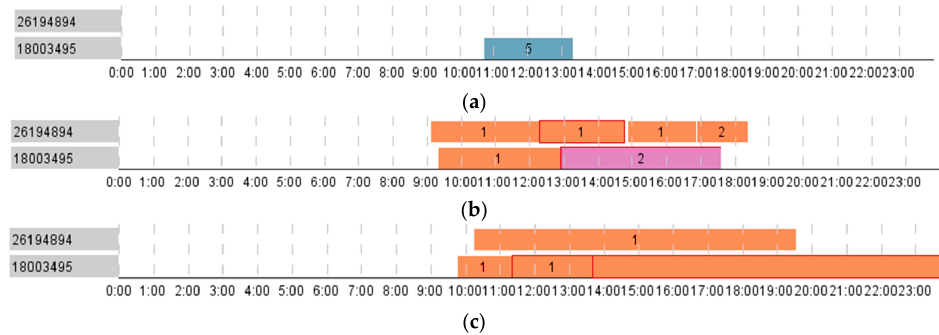
Figure 17. The anomalies in the employees’ routes displayed using BandView: ( a ) working during the day off; ( b ) visiting atypical zone 4-2; ( c ) forgetting using proximity card.